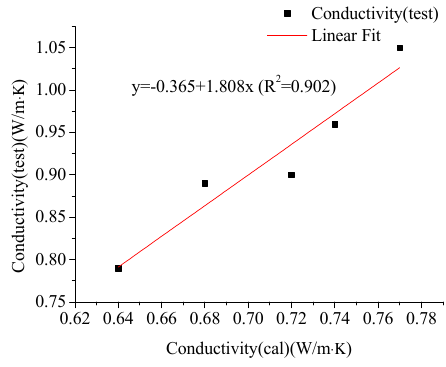
Figure 5. Thermal conductivities of 5 cm thick specimens.